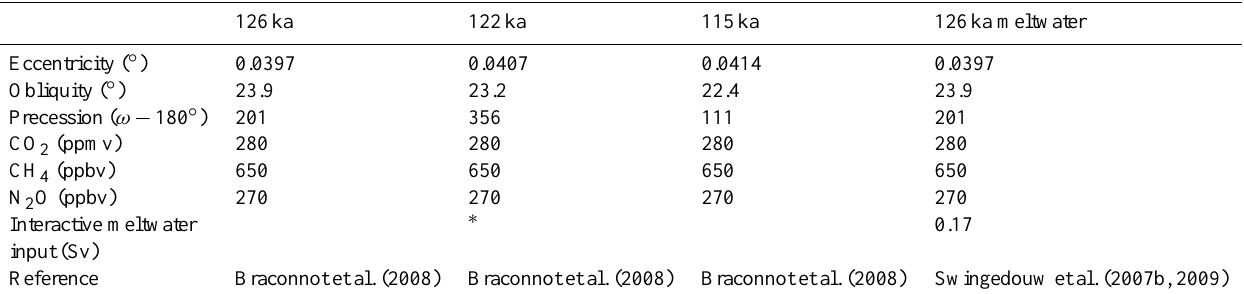
Table 3. Characteristics of the four IPSL-CM4 model simulations considered in this study. The simulations are forced with the modern ice sheet configuration.